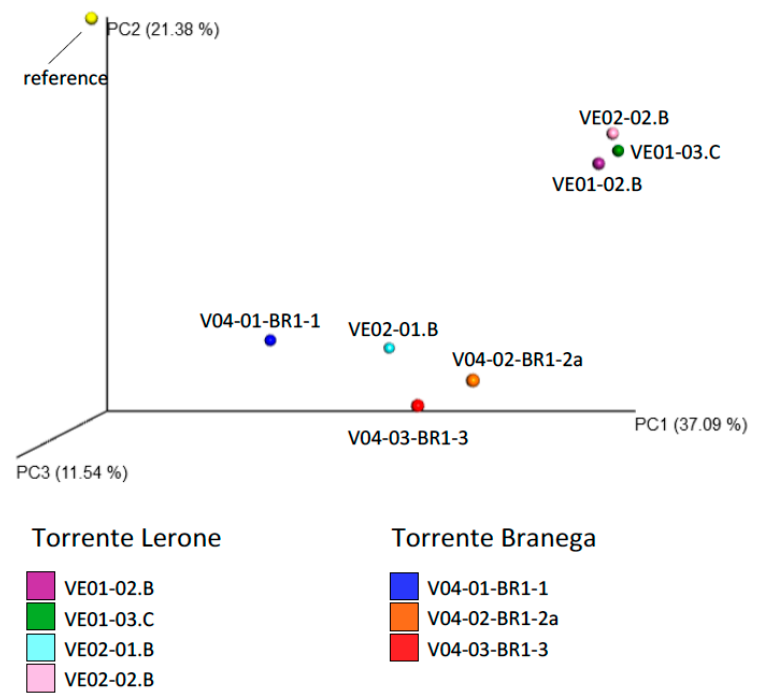
Figure 7. Unweighted principal coordinates analysis (PCoA) plot, depicting all samples as indi ‐ cated.